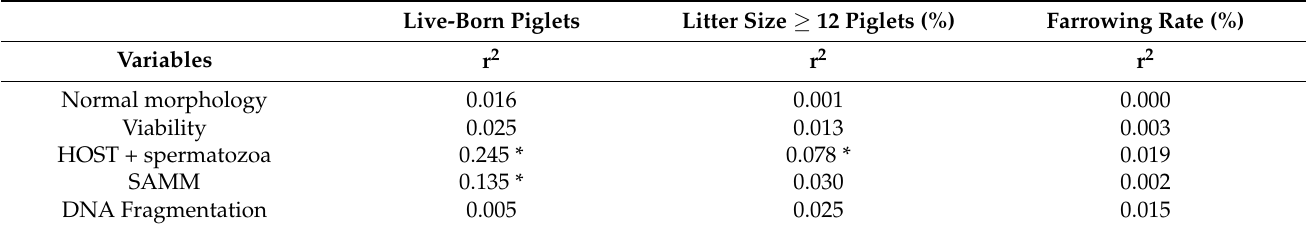
Table 5. Effect of boar semen quality variables on reproductive outcomes.